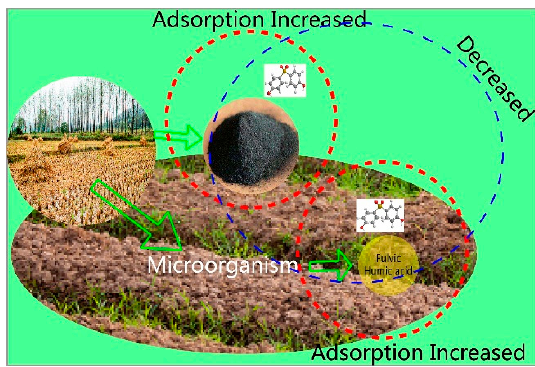
Figure 7. The interaction between soil and DOM.